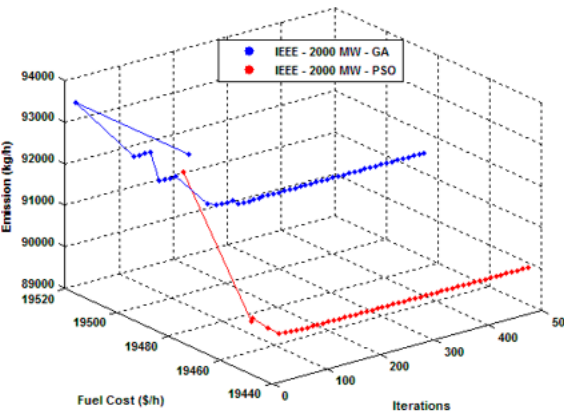
Figure 5. The convergence characteristics of PSO and GA with regard to fuel cost and emission for IEEE 30 bus system with P D = 2000 MW.